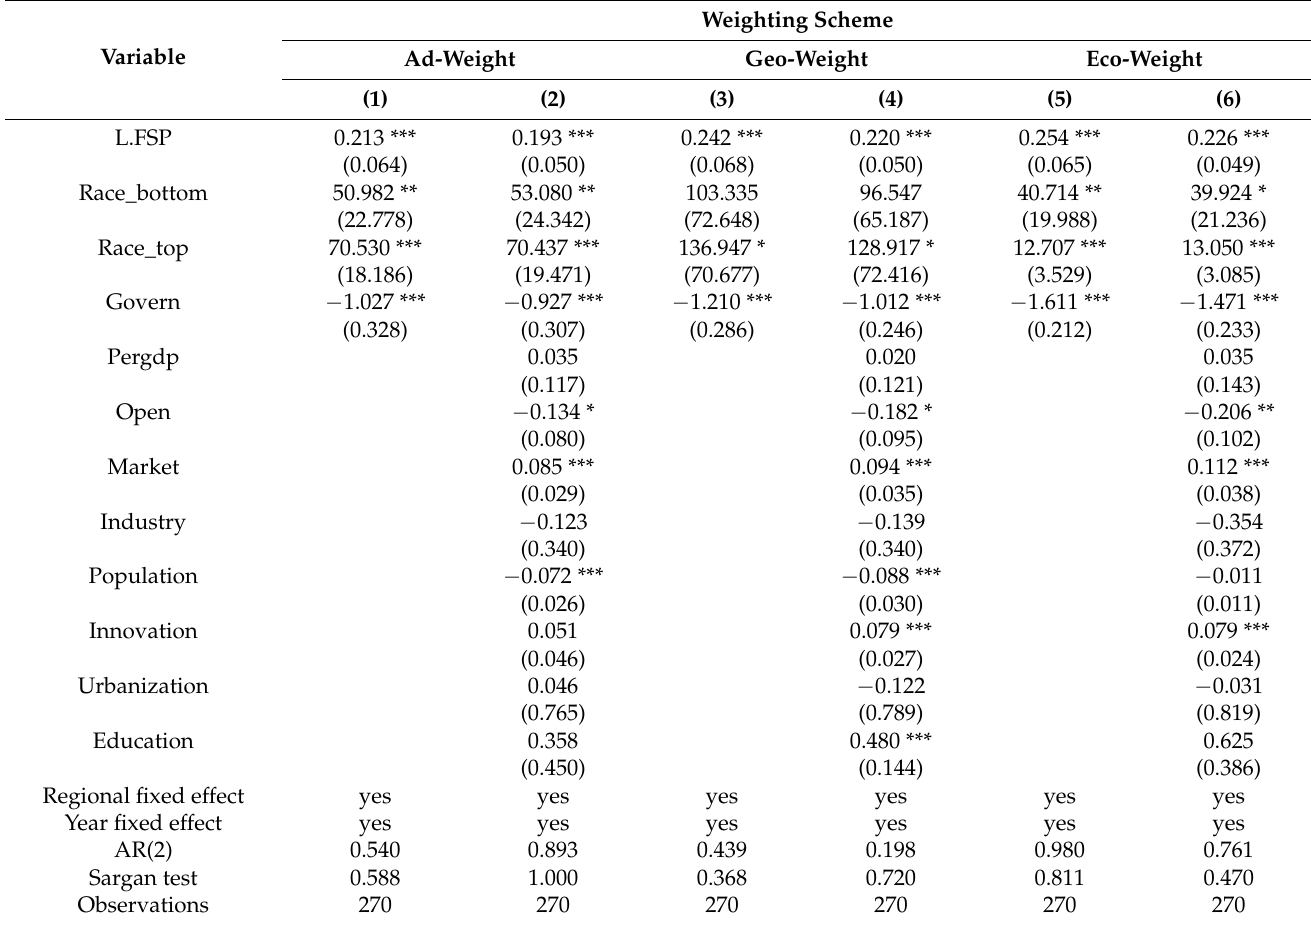
Table 8. Estimation results of asymmetric response